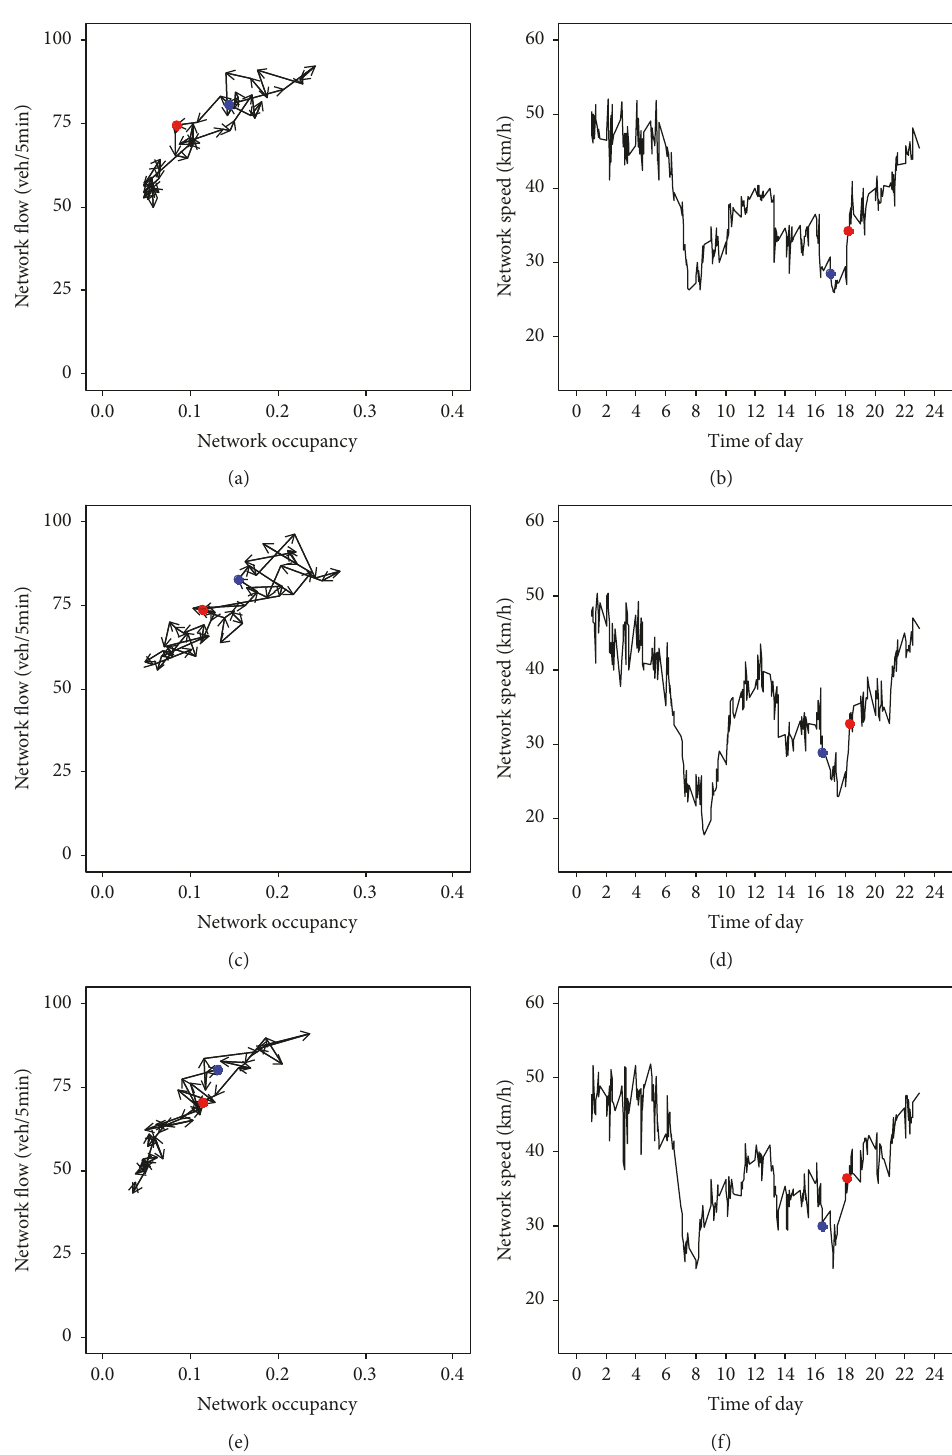
Figure 9: The discrimination results on three typical weekdays. (a), (c), and (e) The identified CTS points in the network flow-occupancy series during afternoon peak of the three days. (b), (d), and (f ) The identified CTS points in the network speed series of the three